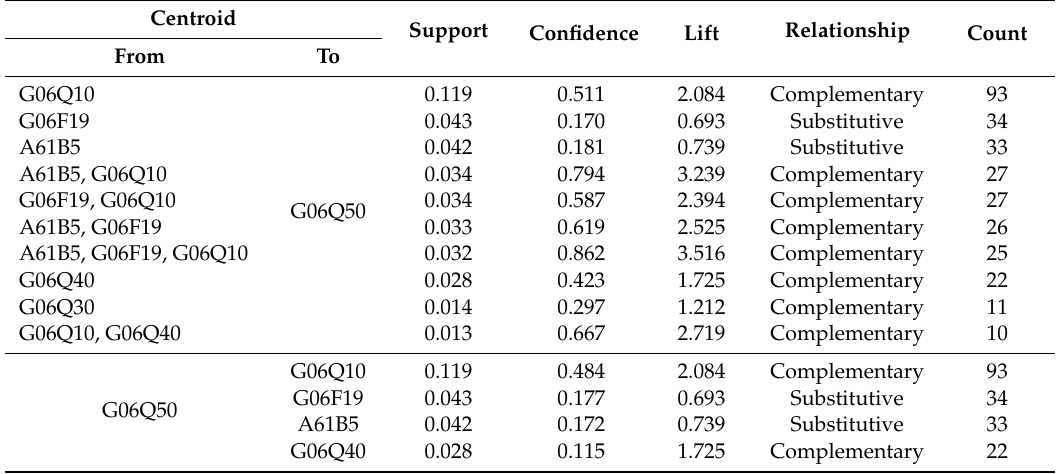
Table A3. Relationships of clusters in the science-based pharmaceutical innovation period (2000–2007). Centroid